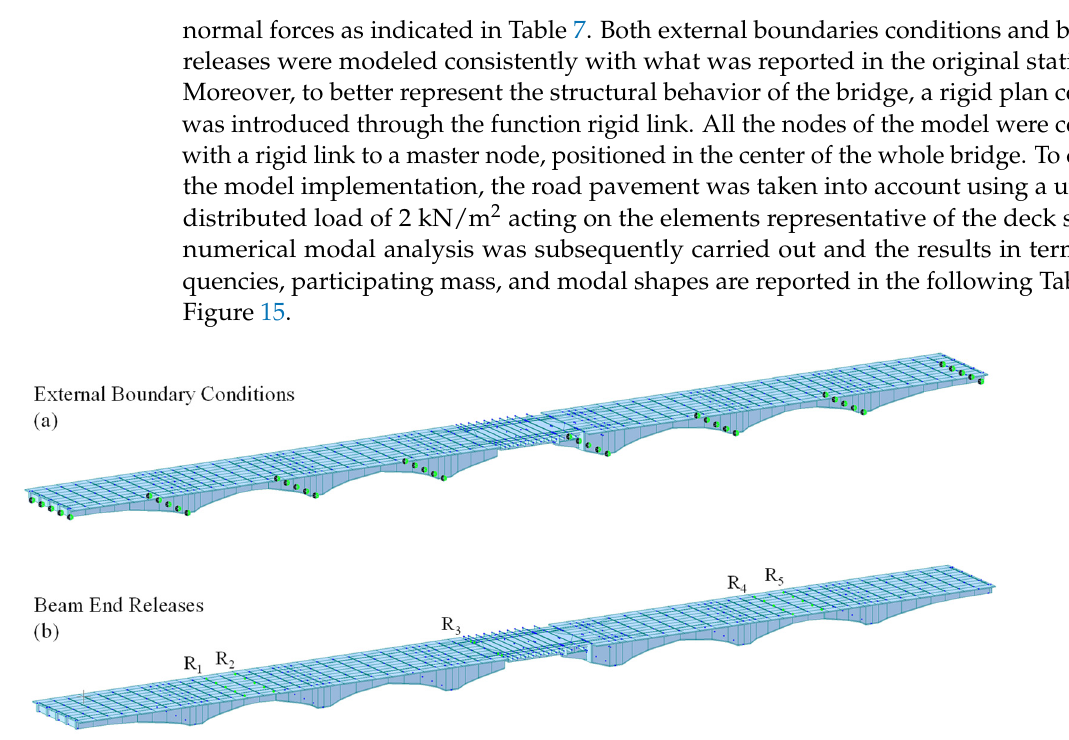
Figure 14. Highlights of the boundary conditions: ( a ) external boundary conditions (hinges) and ( b ) beam end releases applied to simulate the Gerber saddles. Table 7. Typologies of end release applied to simulate the Gerber saddles.